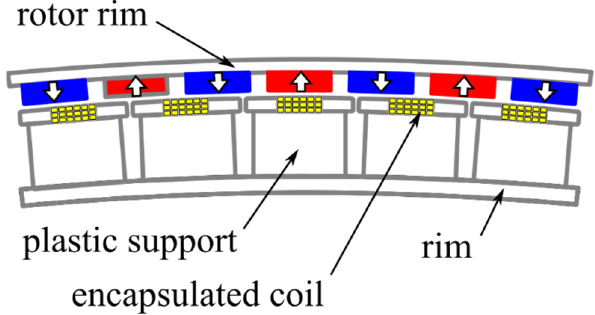
Figure 9. Ironless stator generator design—4.9 MVA, 13 rpm, 95% efficiency [83].